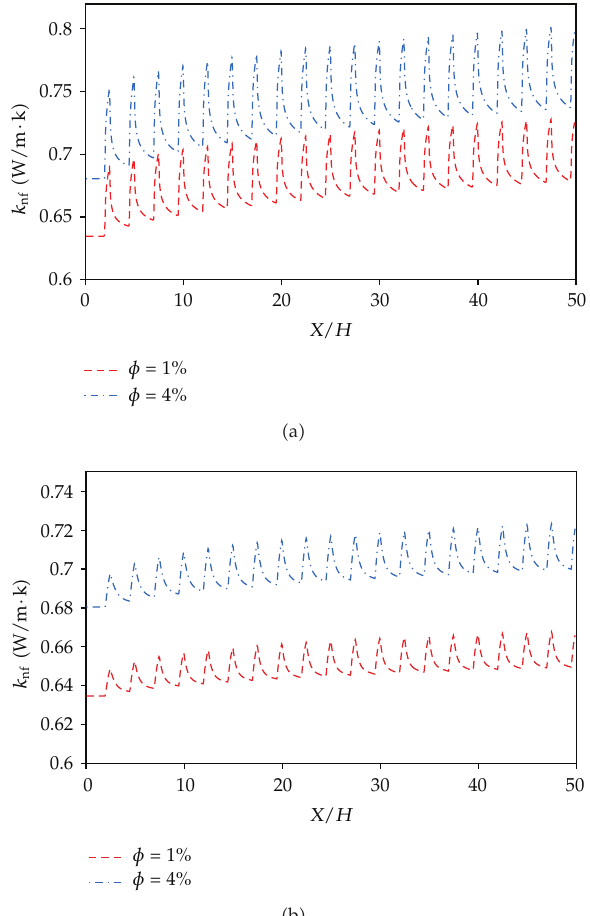
Figure 6: E ff ect of particle loading parameter φ on nanofluid conductivity profile along the channel for: (cid:3) a (cid:5) Re (cid:4) 50, (cid:3) b (cid:5) Re (cid:4)